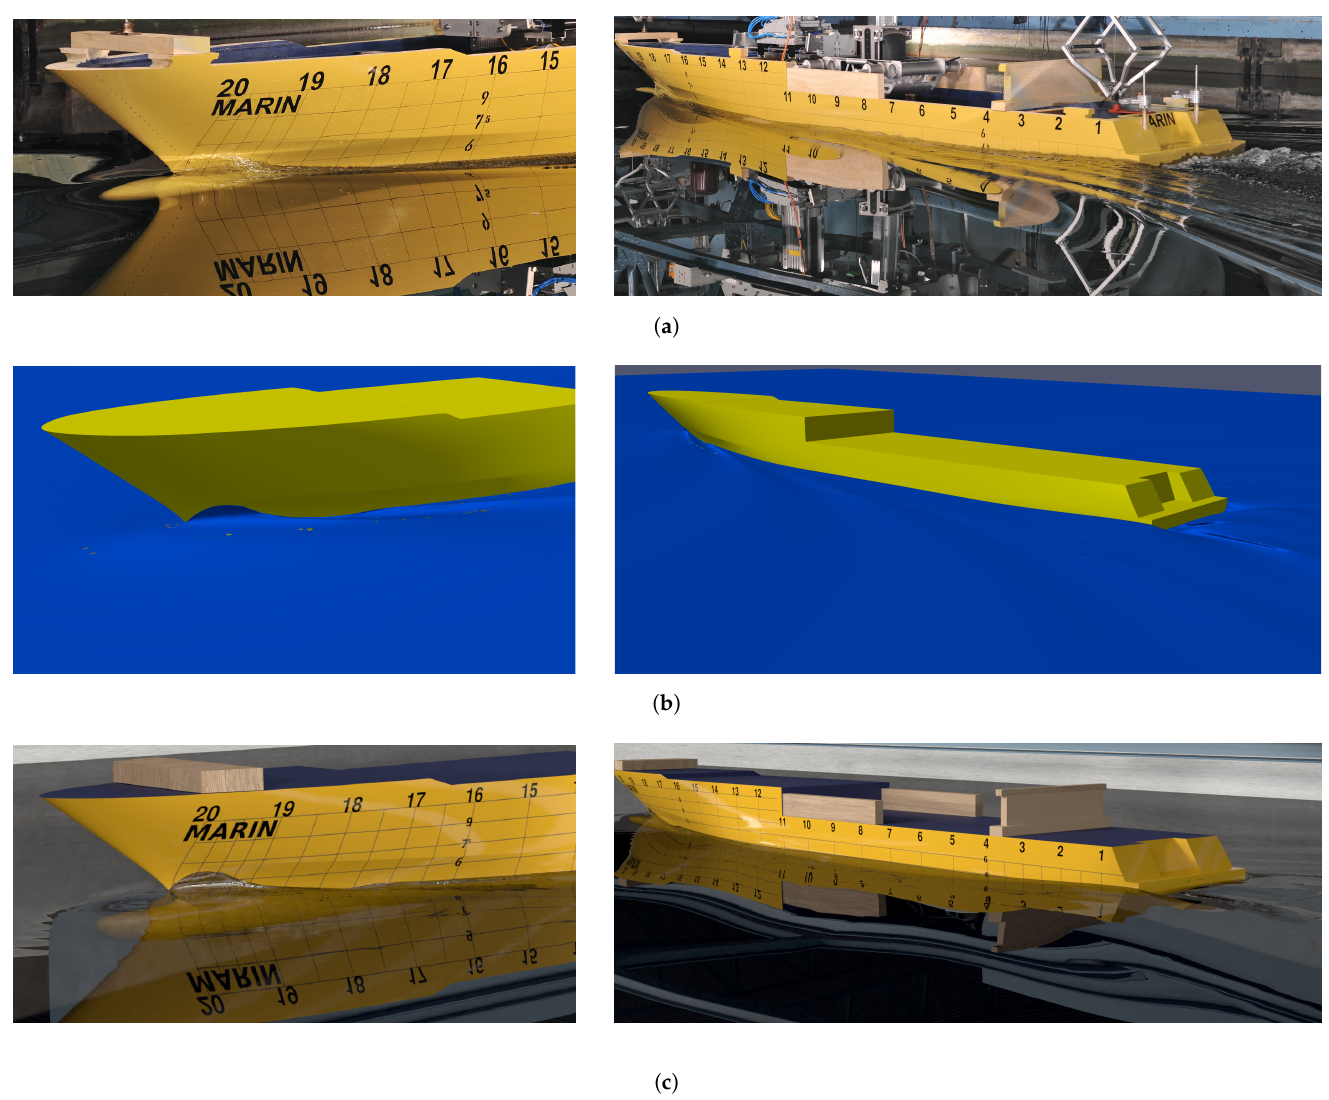
Figure 7. Free-sailing yacht ( a ) experimental observations, ( b ) ParaView, rasterisation, and ( c ) Blender, ray tracing, visu- alisation, focussed on the bow ( left ) and stern ( right ). Free-surface extracted using an air volume fraction iso-contour of